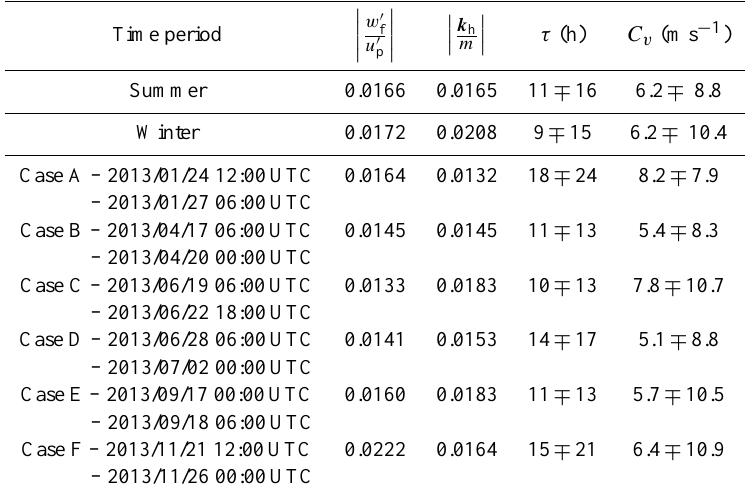
Table 2. Overview of mean properties of IGWs for different seasons and studied cases of strong wave activity. τ is observed period and C v observed phase